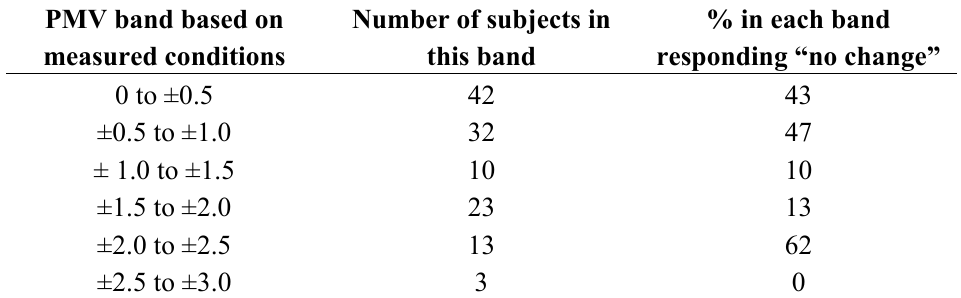
Table 4. Thermal preference votes compared to PMV bands for the circulation zone study (adapted from [11]).